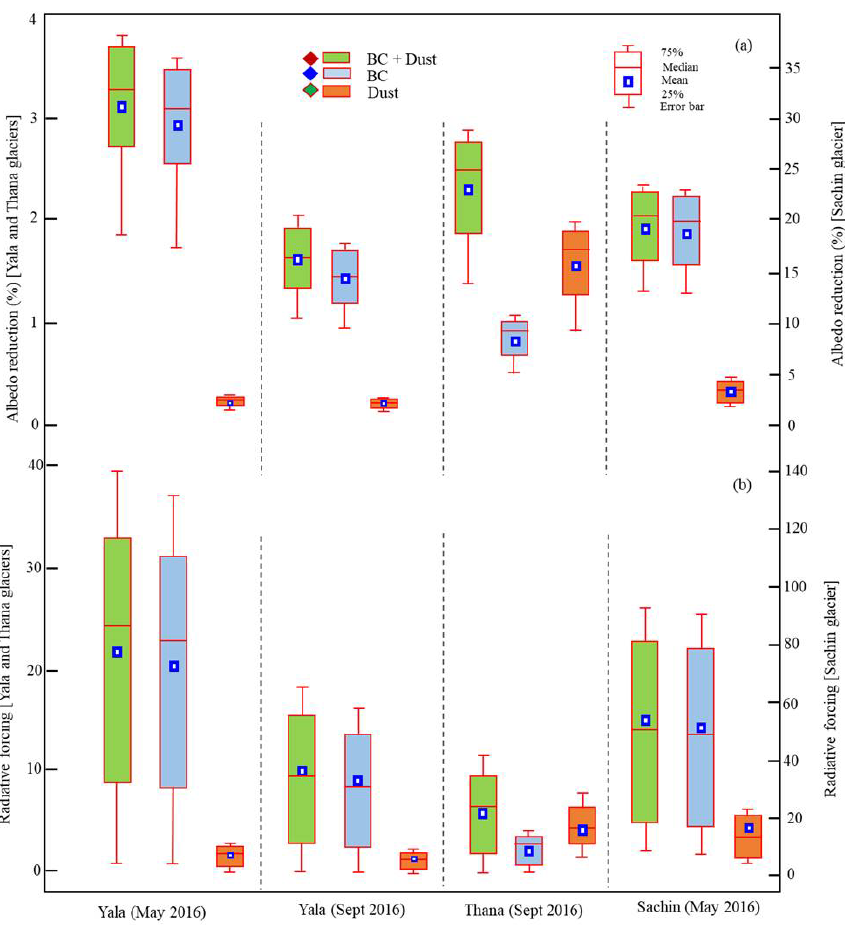
Figure 4. (a) Snow albedo reduction due to black carbon, dust, and combined black carbon and dust during the daytime for a range of solar zenith angles. (b) Average instantaneous radiative forcing based on albedo reduction values during the